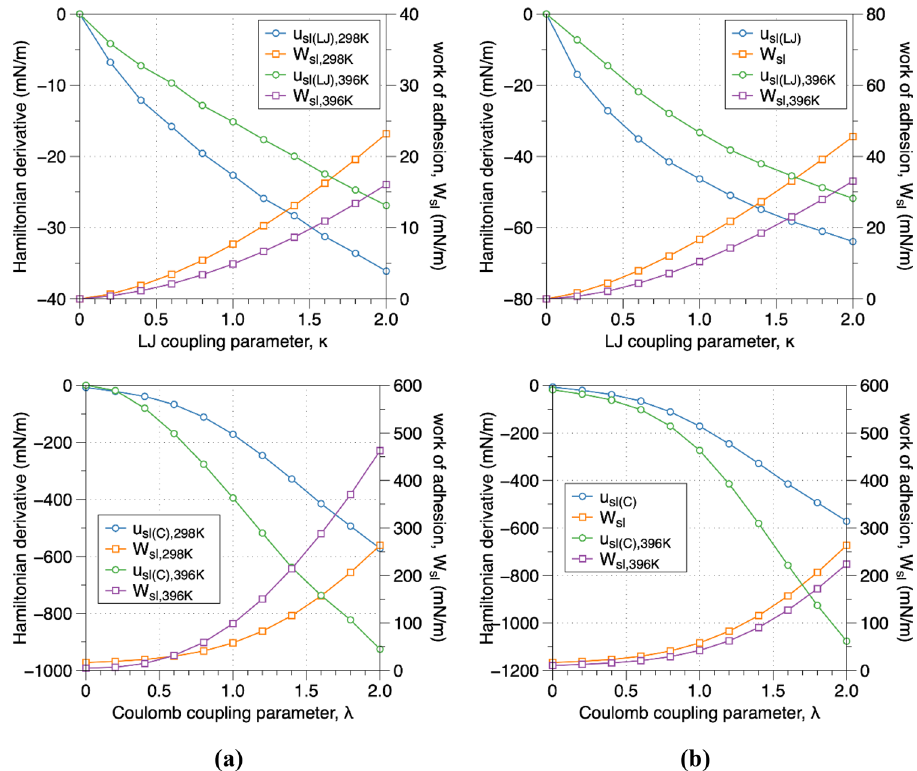
Figure 3. Average of Hamiltonian derivatives (u sl(LJ ) and u sl(C) )and work of adhesion (W sl ) for ( a ) the zirconia (− 111) interface plane at 298.15 K and 396.15 K and ( b ) the zirconia (001) interface plane at 298.15 K and 396.15 K respectively. The work of adhesion (W sl ) at κ = 1 on the LJ coupling parameter case was used as the initial value for the work of adhesion using the Coulomb coupling parameter. The cumulative W sl (at λ equal to 1.0) of the Coulomb coupling parameter was applied in the Young-Dupré equation to calculate the water contact